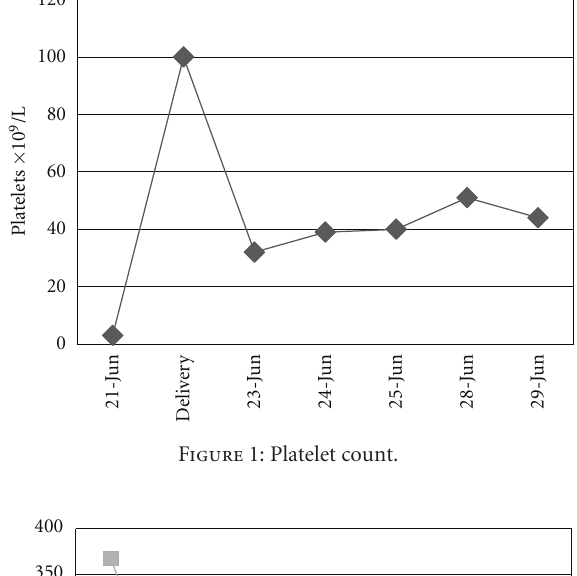
Table 1: Causes of thrombocytopenia during pregnancy [5].